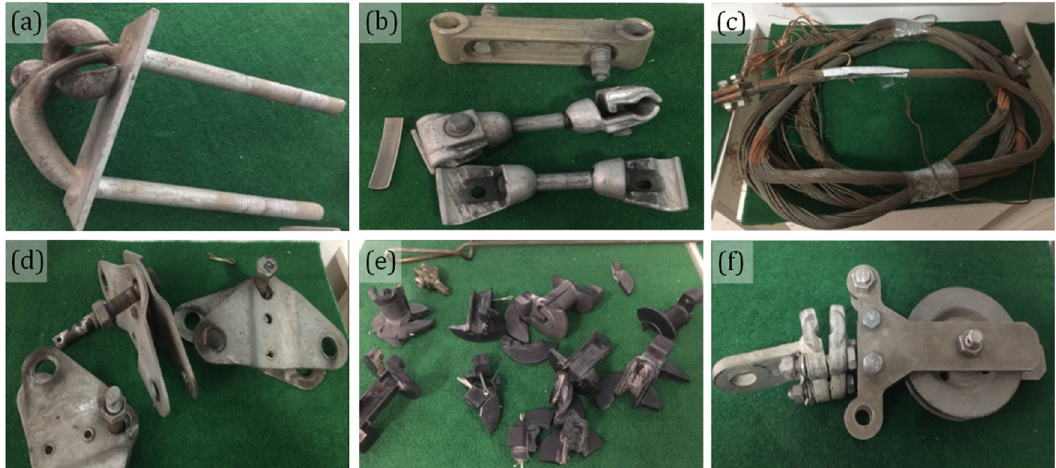
Figure 1: Wind - induced failures of railway catenary components from field investigation. ( a ) Abrasion of ball - head hanging ring; ( b ) wire clamp breakdown; ( c ) electric link fracture; ( d ) binaural link plate detachment; ( e ) dropper nylon sleeve detachment; ( f ) suspension pulley clamping